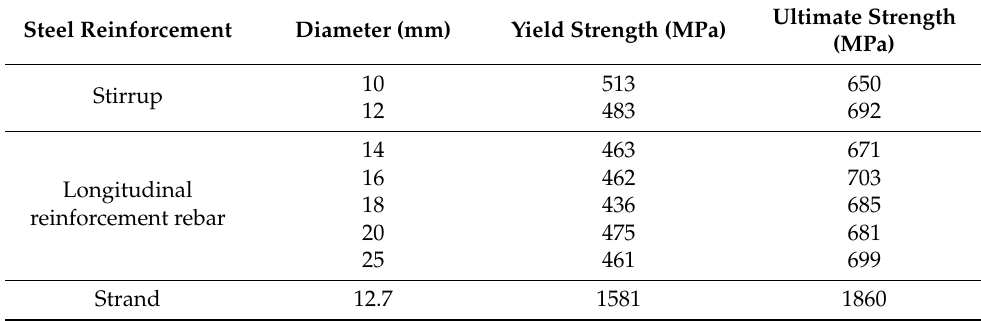
Table 4. Mechanical parameters of rebars and strands.